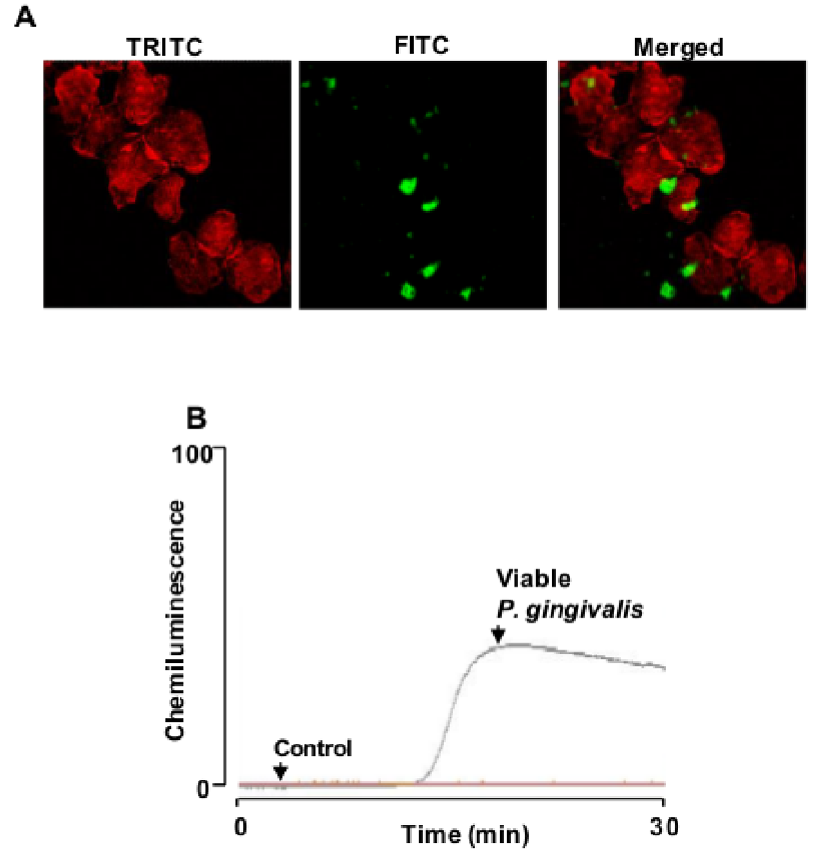
Figure 2. P.gingivalis is able to attach and induce ROS production in Jurkat T-cells. A - Jurkat T-cells cells were stimulated with FITC-labeled P. gingivalis (10 8 CFU/ml, MOI:100) for 24 h and analyzed by confocal microscopy. Magnification is 6 63, with a 2 6 digital zoom. B - ROS production in Jurkat T-cells was detected by luminol-amplified chemiluminescence following treatment with 10 8 CFU/ml of viable P. gingivalis (MOI:100) for 30 min. Shown is a representative graph of five independent experiments.